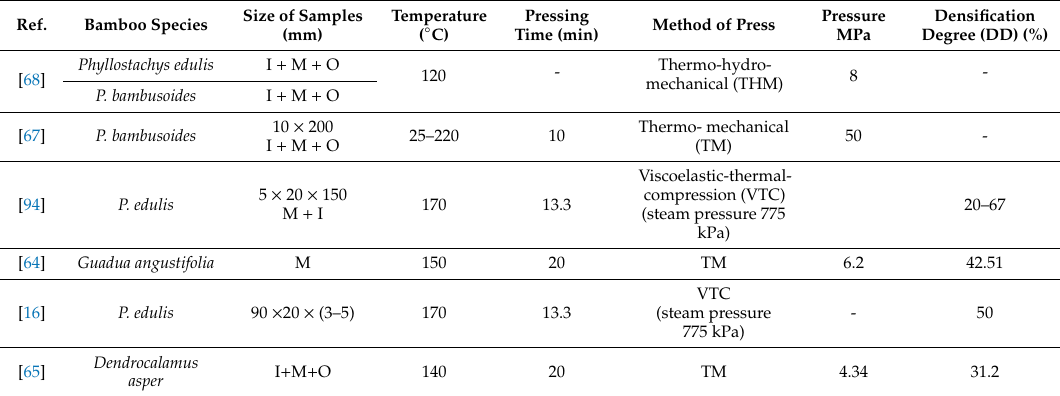
Table 2. Bamboo densification process